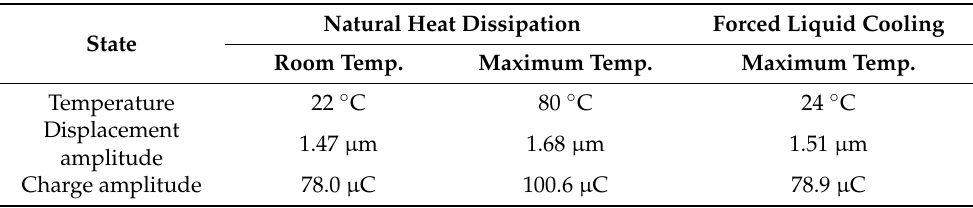
Table 3. Temperature, displacement, and charge amplitudes when a bias voltage of 50 V and sinusoidal voltage of 24 V at a frequency of 10 kHz are applied to the PESA.